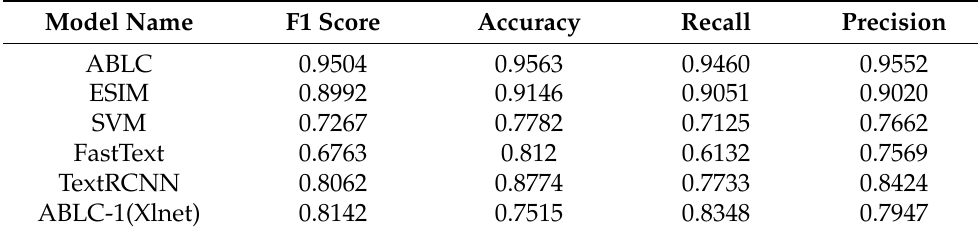
Table 7. Experiment results on comparison